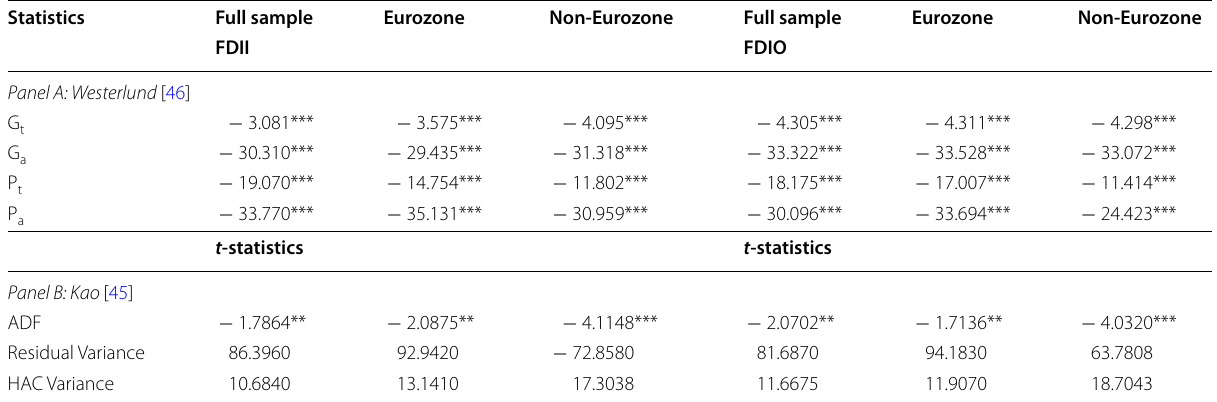
Table 4 Panel cointegration